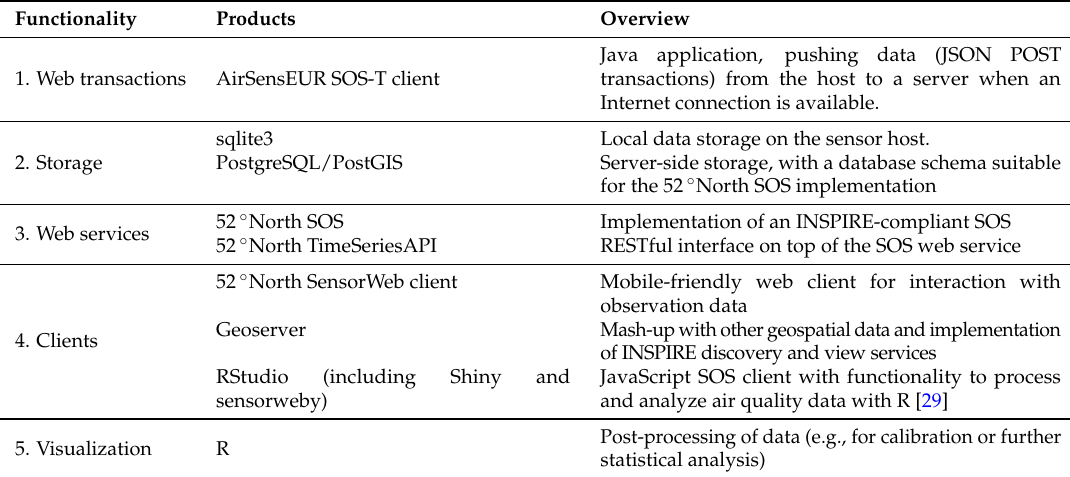
Table 2. Open source software products used in